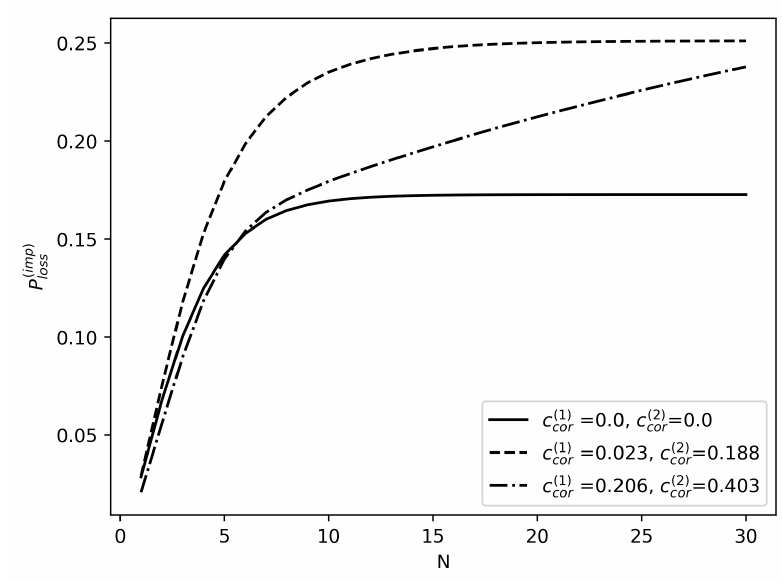
( imp ) as a function of the buffer capacity N for BMMAP s with different loss